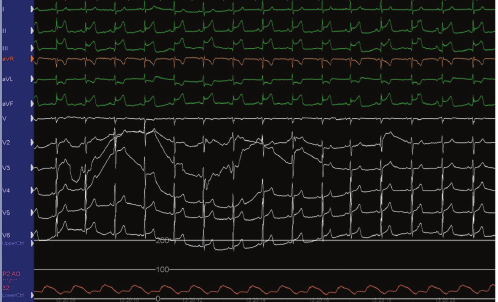
Figure 3: The electrocardiogram showed ST-segment elevation in leads II, III, and aVF. Aortic blood pressure with intra-aortic balloon pumping was < 50 mmHg.